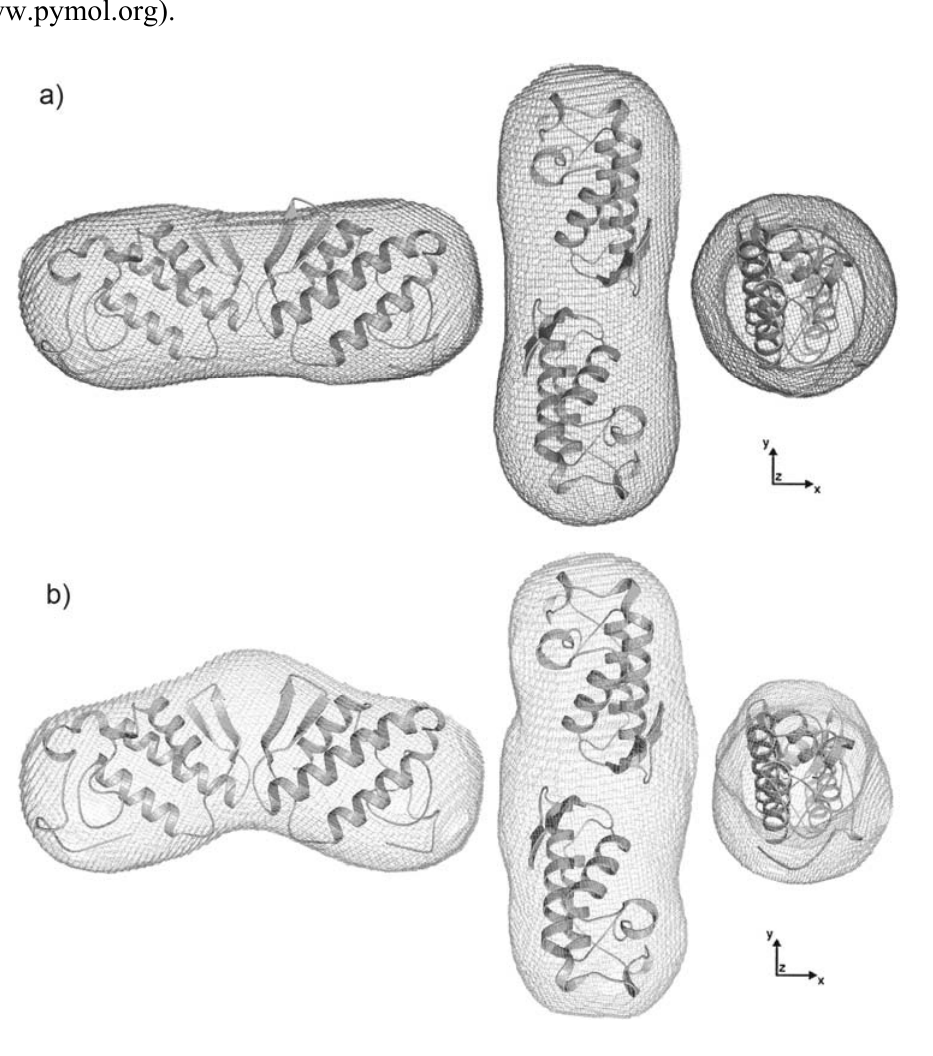
Figure 7. Superimposition of the dimeric high resolution model for agkistrodotoxin sPLA2 (PDB entry 1BJJ, chains A and E) is shown as a cartoon, and SAXS envelopes are shown in dark gray and light gray. (a) The native low resolution model obtained is shown in dark gray. (b) The envelope of the protein after treatment with naringin is shown in light gray. Envelopes (left) are rotated clockwise by 90° around the y- (middle) and z-axes (right). This figure was prepared using PyMOL (DeLano Scientific, San Carlos,